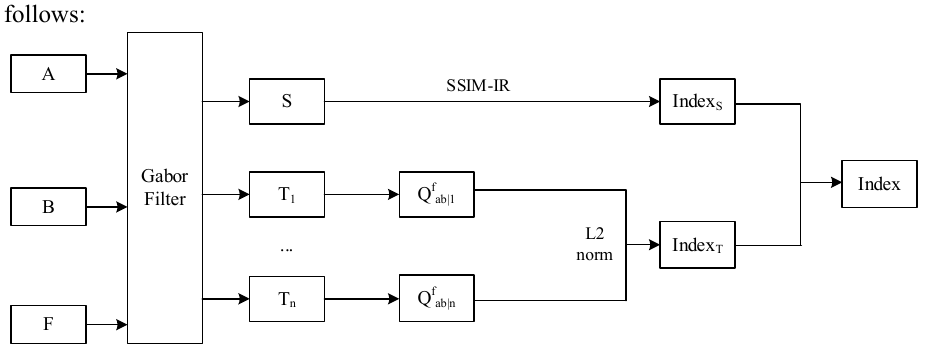
Fig. 1. Evaluation index construction framework (S, T 1 and T n Represent structure image set and multi-angle texture image set